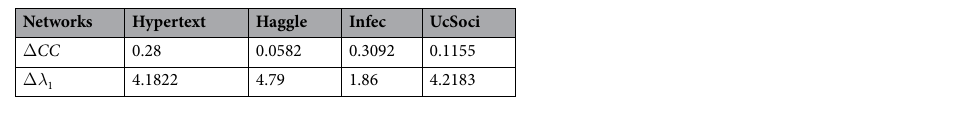
Table 4. Variation of correlation coefficient Δ CC and coupling influence Δ λ 1 . Each data is averaged over ten